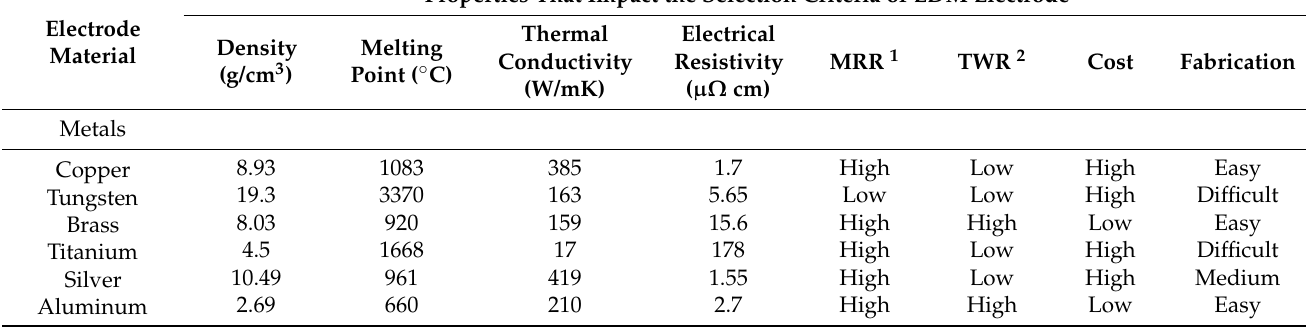
Table 3. Electrode classification and its properties